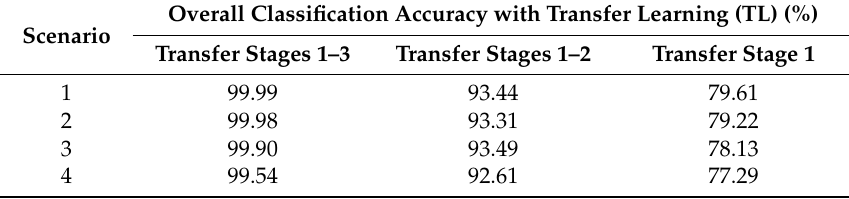
Table 5. Impact on overall classification accuracy of different numbers of stages for